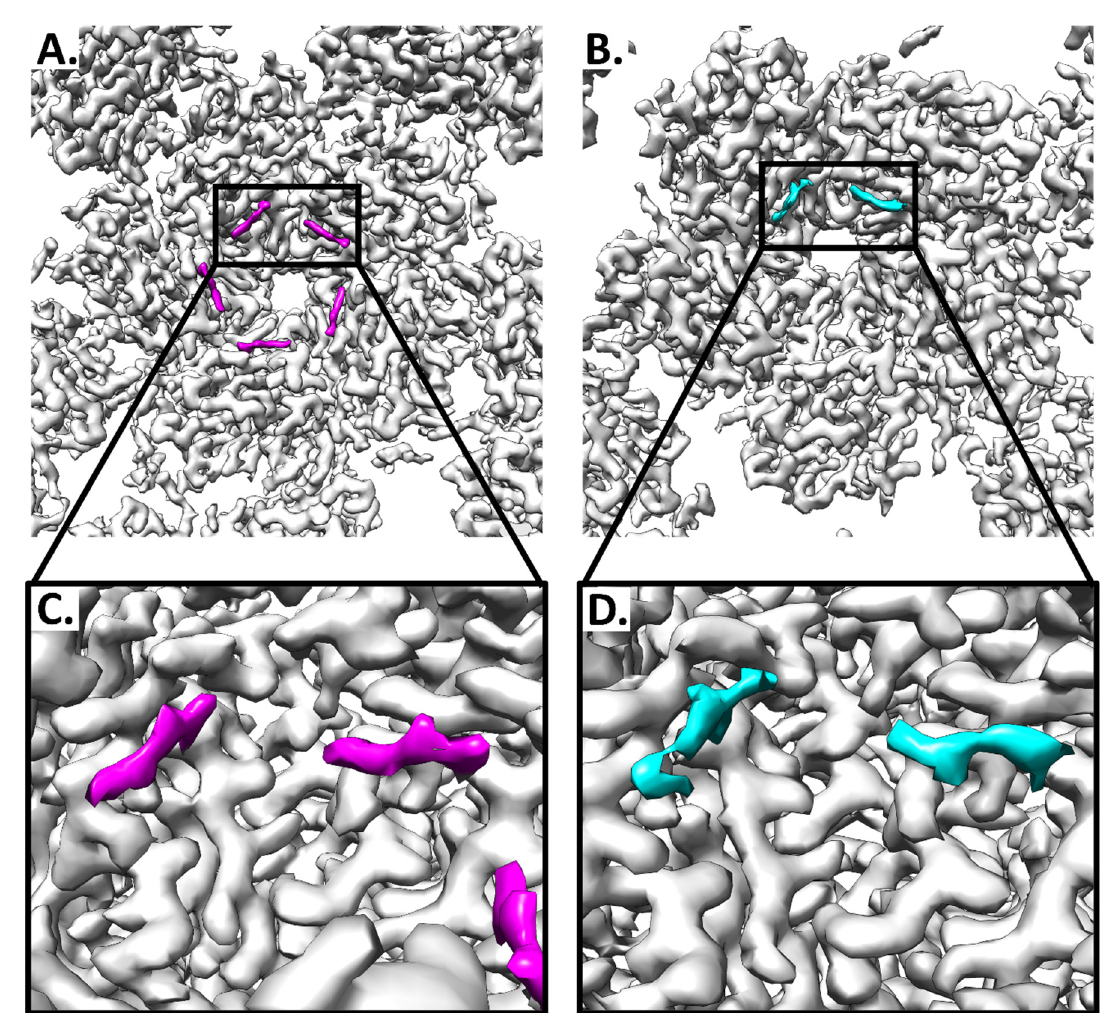
Figure 5. Non-L1 protein density maps to the interior of pentavalent and hexavalent capsomers. The recombined capsid map is colored (gray) within 2 Å of the continuous L1 protein chain. The discontinuous protein volumes (magenta and cyan) are unfilled by L1. ( A ) The pentavalent capsomer has 5 stretches of putative L2 density, each of which flanks one of the 5 copies of chain A that make up the pentavalent capsomer. ( B ) The hexavalent capsomer has 2 distinct stretches of putative L2 density, each flanking chain C and D of the hexavalent capsomer at the threefold. ( C , D ) Zoom of the putative L2 protein density from each capsomer environment.